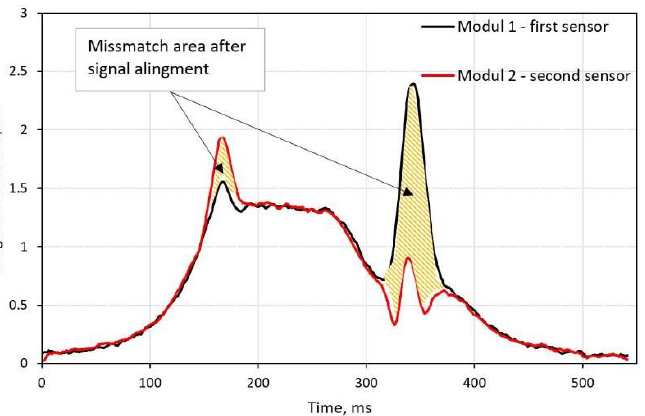
Figure 4. Signal similarity estimated by calculating relative mismatch area between two curvatures. Alignment is based on lag value from the cross-correlation method.